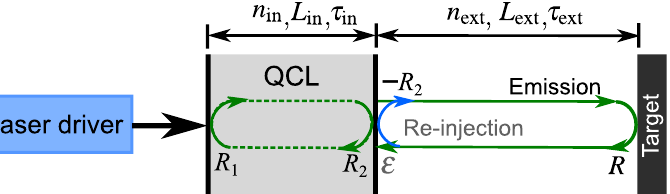
Figure 1. Model of a QCL under optical feedback with multiple external cavity round trips, where R 1 , R 2 , and R are the reflection coefficient of the laser facets and the external target, respectively, and ε is the reinjection coupling factor. The blue arrow indicates the reflection of the THz beam when it is trying to return to the laser cavity after being reflected from the external target, with the reflection coefficient − R 2